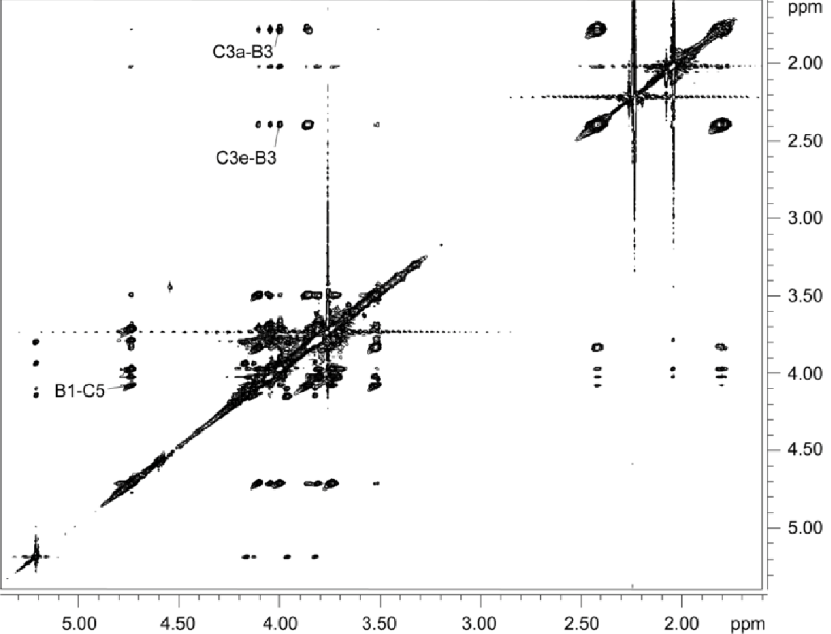
Figure 4. 2-D NOESY NMR spectrum of the polysaccharide. The sequence-determining correlations are labeled. For numbering, see Table 3.